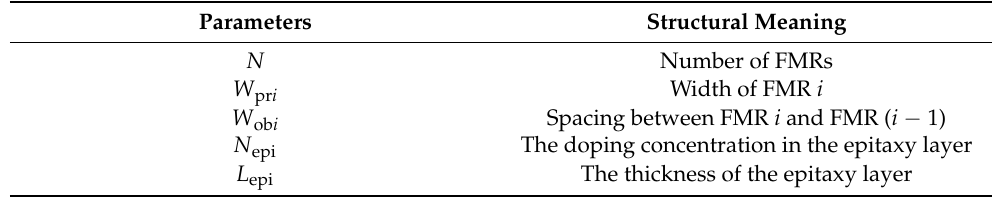
Figure 2. Device structure of SBD with FMR, where main SBD is connected directly to the ground or applied voltage, while FMRs are floating electrodes. ( a ) Cross-sectional view of the device with 3 FMRs. ( b ) Top view of the device with 3 FMRs. Table 2. Structural simulation parameter table.